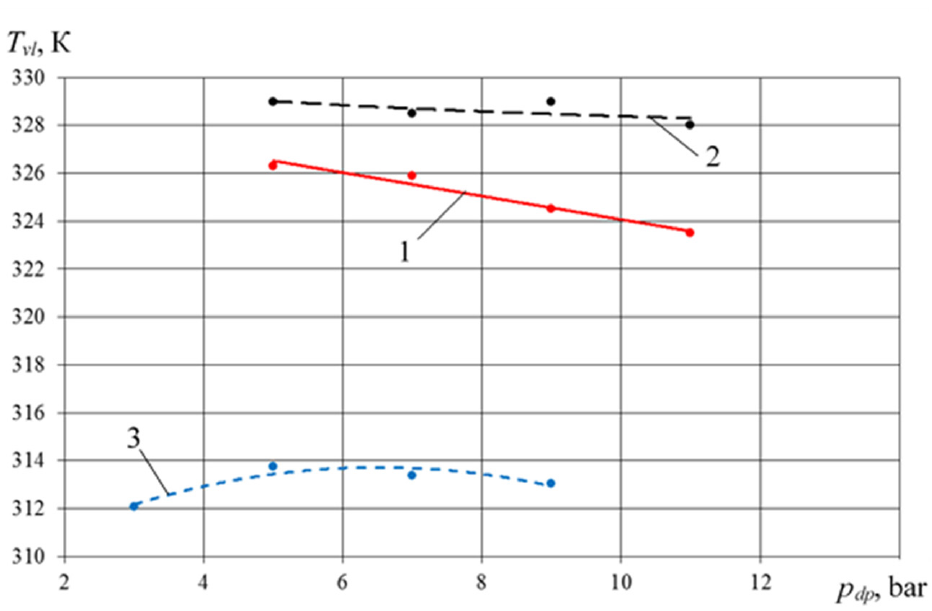
Figure 26. Dependence of the temperature of the valve body on the discharge pressure of the pump section (1—PHPM with step-type gap seals; 2—PHPM with smooth gap seals; 3—Crosshead-free PHPM).